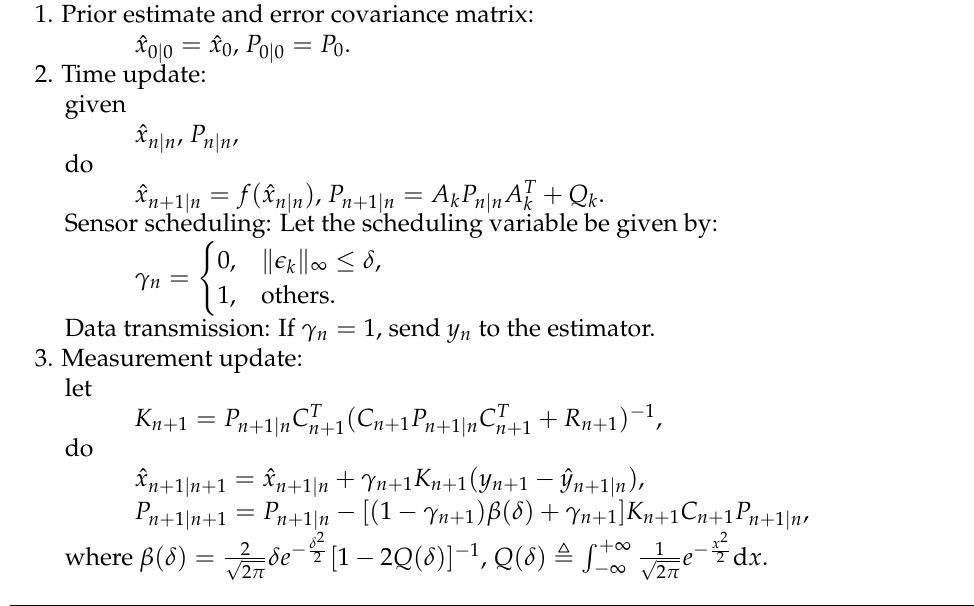
Algorithm 1 Event-triggered EKF